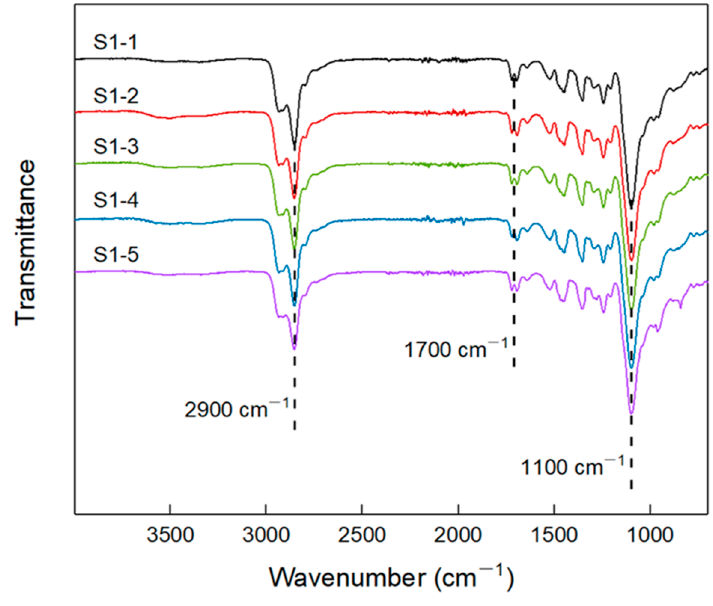
Figure 2. FTIR spectra of elastomers S1-1~S1-5.